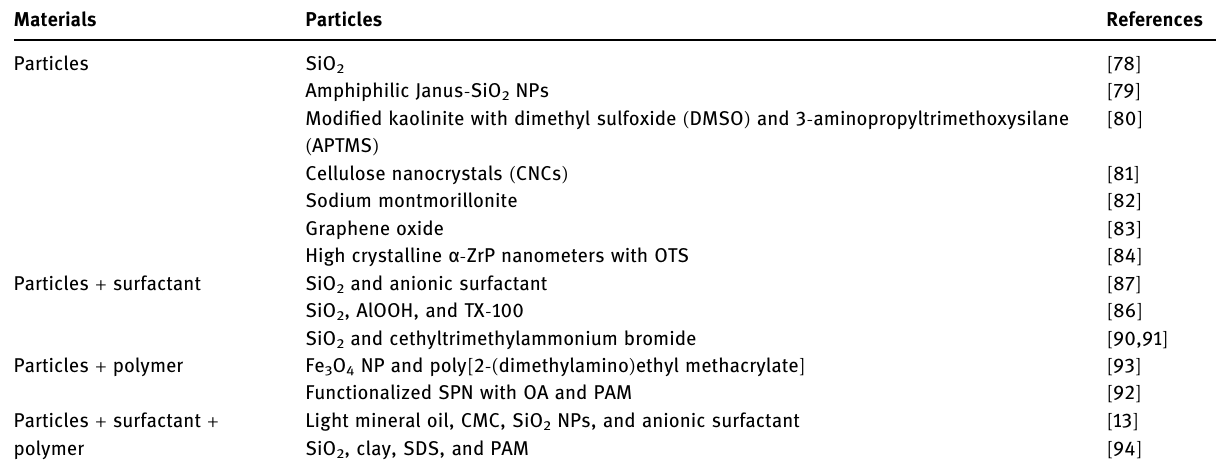
Table 1: Pickering emulsion as oil displacement agent for EOR